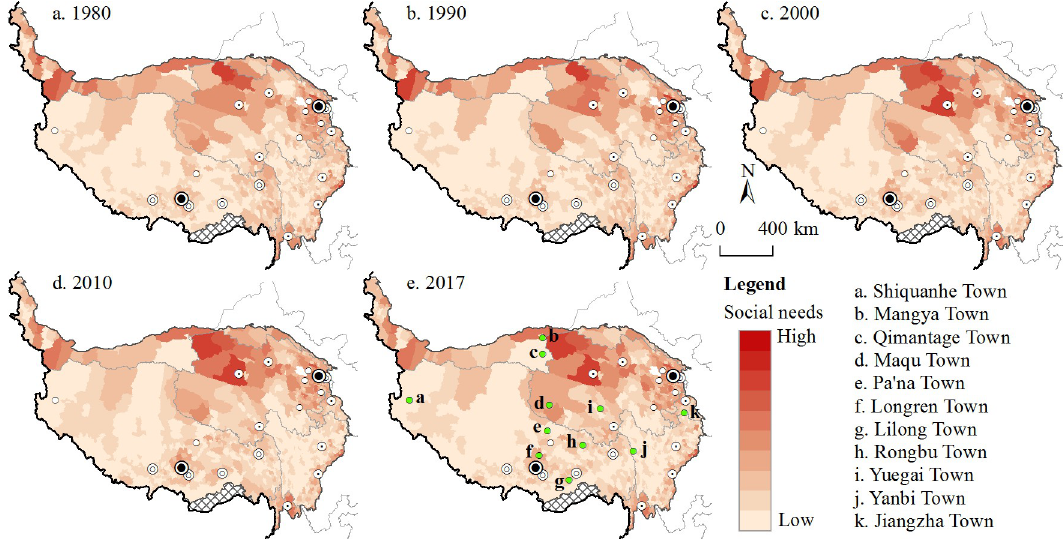
Fig 5. Distribution of social demand deciles from 1980 to 2017.